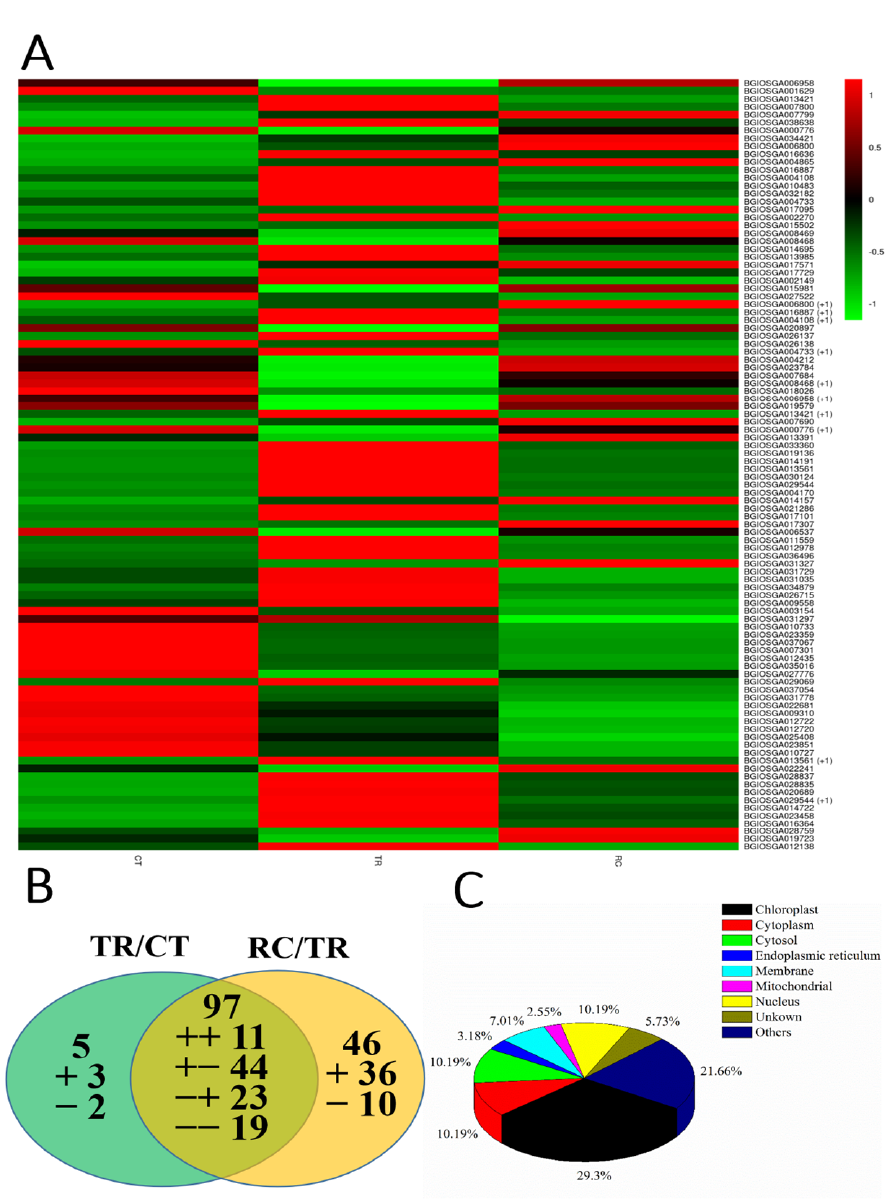
Figure 7. ( A ) Heatmap analysis of the common genes under three different temperature treatments. CT: Normal-temperature treatment. TR: Chilling treatment. RC: Recovery to normal-temperature treatment. ( B ) Venn diagram of differentially expressed genes that were upregulated or downreg- ulated by chilling stress or recovery. TR/CT: From normal temperature to chilling. RC/TR: From chilling recovery to normal temperature. The green circle on the left shows that the genes are differen- tially expressed only in TR/CT. The intersection in the middle represents the genes are differentially expressed in both TR/CT and RC/TR. The yellow portion on the right shows the genes that are differentially expressed only in RC/TR. The “+” and “ − ” indicate upregulated and downregulated genes, respectively. The “+ − ” indicates genes with upregulated expression under TR/CT and RC/TR treatments. The “+ − ” indicates genes with upregulated expression under TR/CT and downregu- lated expression under RC/TR. The “ − +” indicates genes with downregulated expression under TR/CT and upregulated expression under RC/TR. The “ −− ” indicates genes with downregulated expression under TR/CT and RC/TR. ( C ) Subcellular localization of 149 differentially expressed genes under chilling and/or subsequent